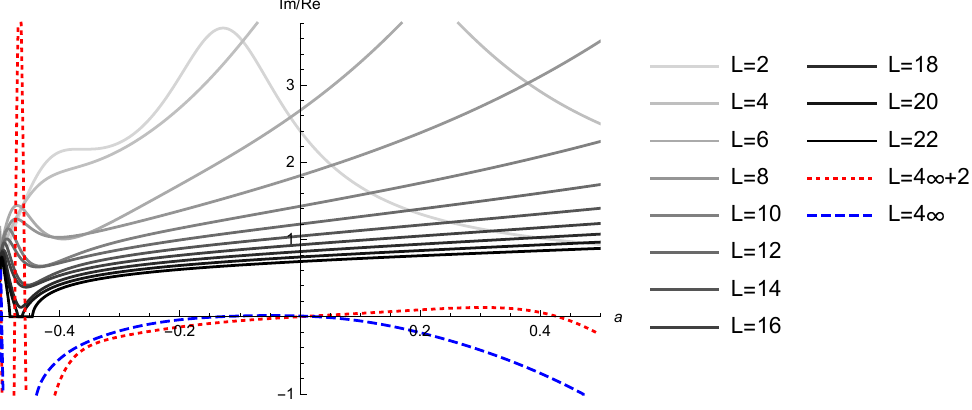
Figure 8 . Plots of Im / Re (2.22) for the “double brane” solution Φ D horizontal axis denotes the value of the parameter a .